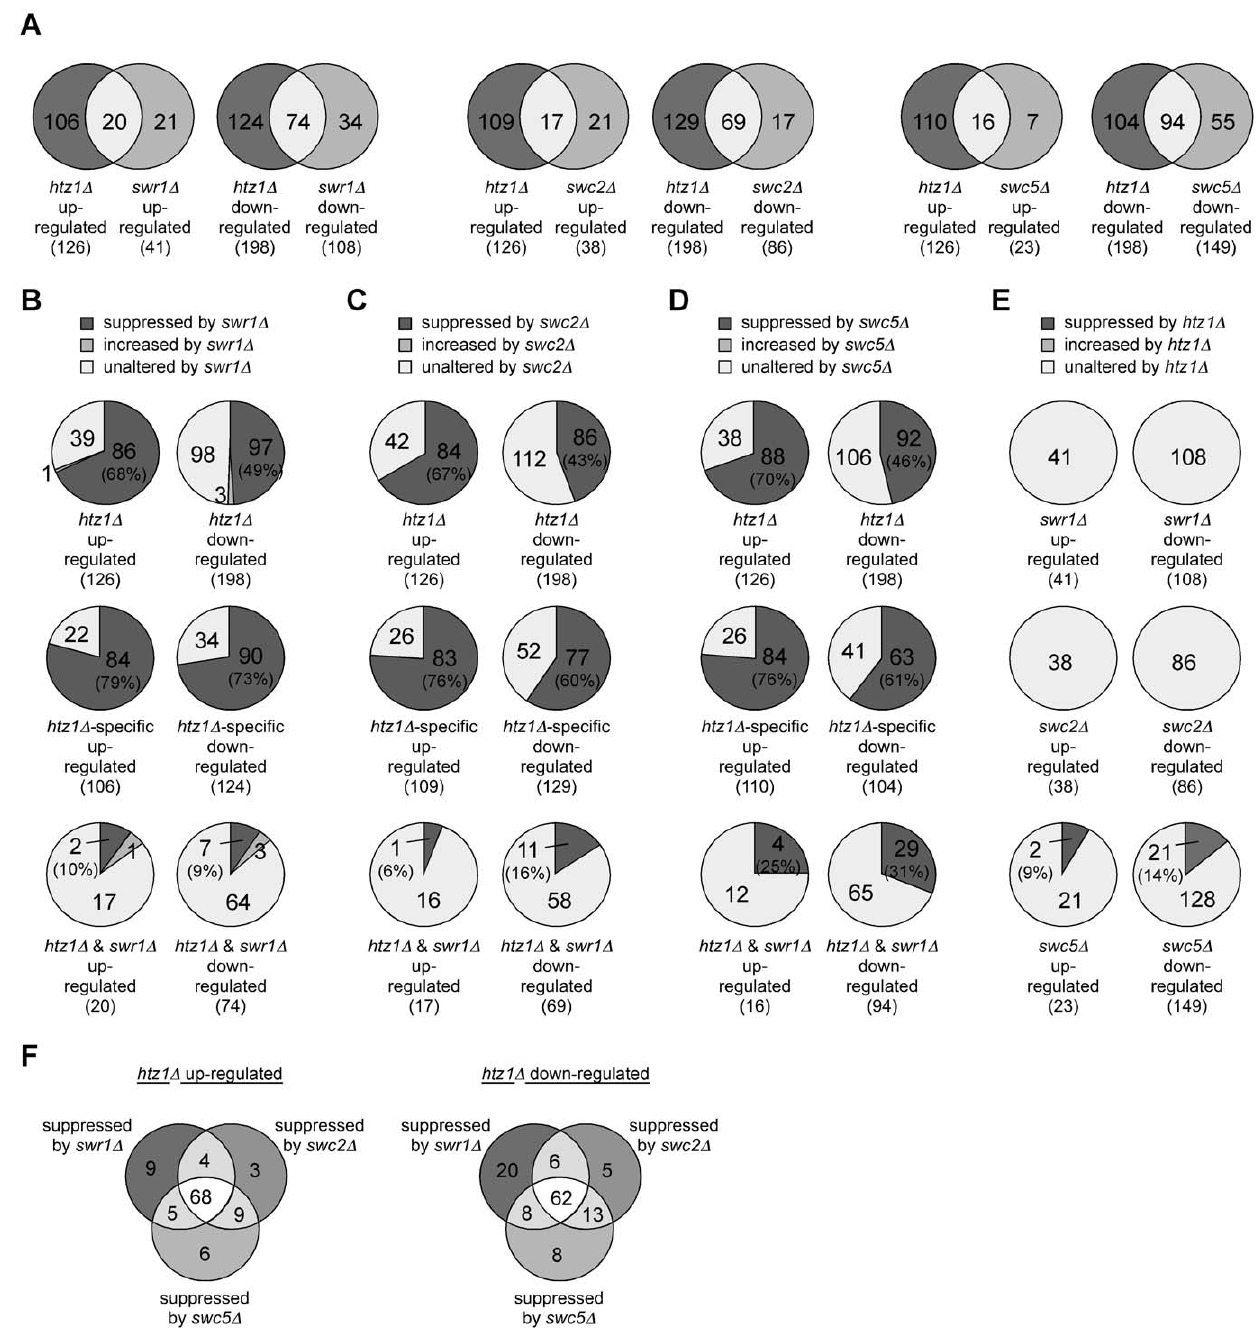
Figure 5. The SWR1 complex causes transcriptional misregulation in the absence of Htz1. ( A ) Venn diagrams showing the number of genes whose mRNA levels changed by more than 2-fold in mutants relative to the wild type and the number of genes that were commonly misregulated by htz1 D and either swr1 D , swc2 D or swc5 D . ( B, C, D ) Fraction of htz1 D misregulated genes (2-fold cutoff) whose mRNA levels were changed by more than 1.5-fold (either suppressed or increased) in the double mutant htz1 D swr1 D (B), htz1 D swc2 D (C) or htz1 D swc5 D (D) relative to htz1 D . ( E ) Fraction of swr1 D , swc2 D or swc5 D misregulated genes (2-fold cutoff) whose mRNA levels changed by more than 1.5-fold in htz1 D swr1 D , htz1 D swc2 D or htz1 D swc5 D relative to swr1 D , swc2 D or swc5 D , respectively. ( F ) Venn diagrams showing the number of htz1 D -misregulated genes (2- fold cutoff) that were commonly suppressed by swr1 D , swc2 D and swc5 D . The genome-wide transcriptional analysis was performed in BY4741.